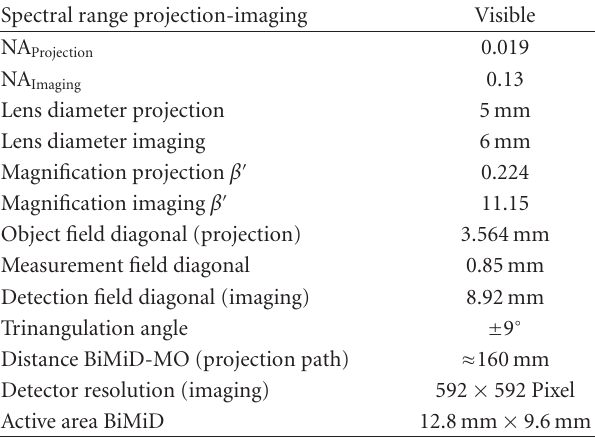
Table 1: System parameters of the paraxial lens design of the 3D sensor system (see Figure